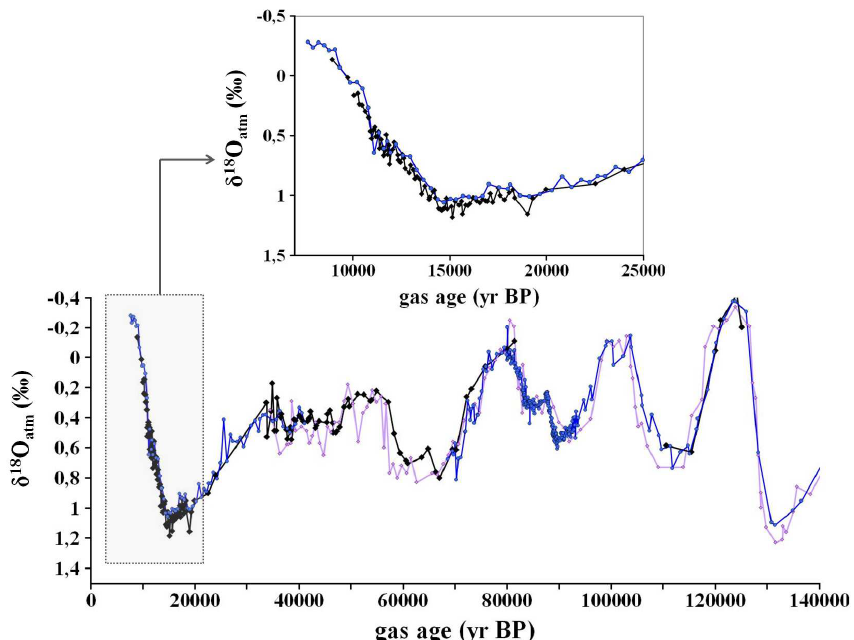
Fig. 6. δ 18 O atm measured along the TALDICE ice core (black line and symbols) on the TALDICE-1 age scale, compared with its counterparts from EDML (blue line with rounded symbols; Capron et al., 2010) and Vostok (purple line; Petit et al., 1999). Inside frame: zoom on the LGM and the last deglaciation.